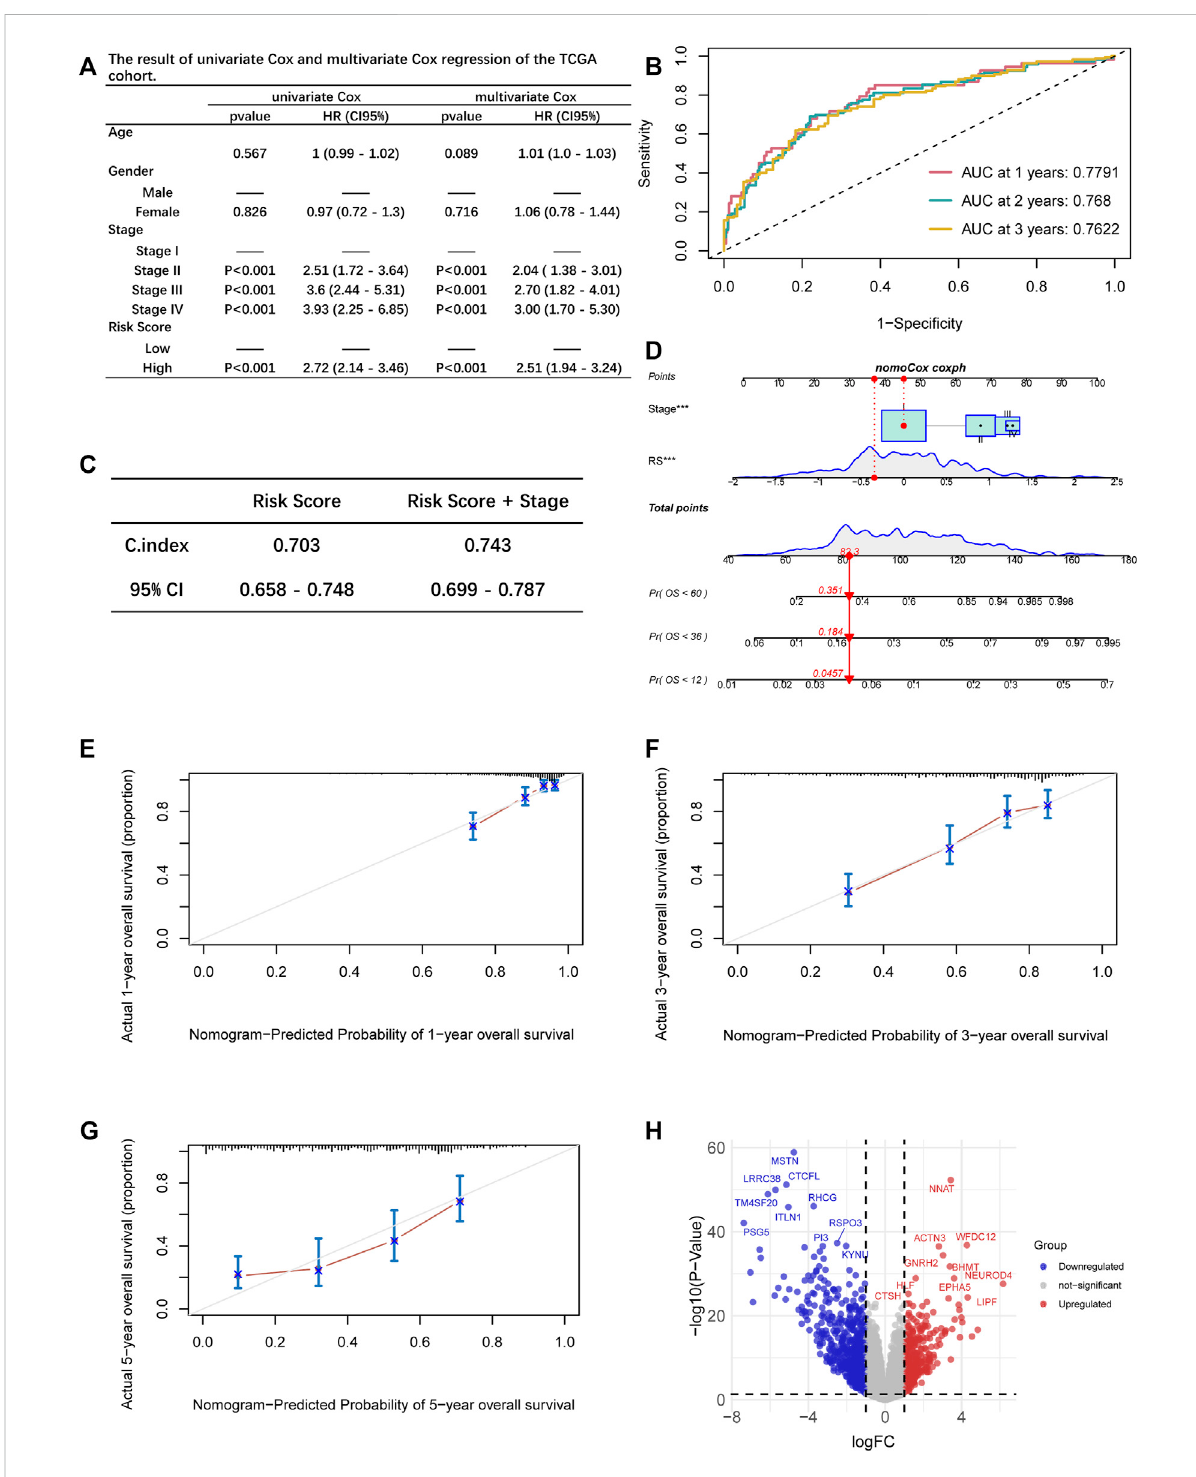
FIGURE 5 (A) Uni- and multivariate Cox regression analysis of the associations between survival outcomes and age, gender, stage, and risk score of LUAD patients. (B) ROCcurvesofone-,two-,and3-yearOSforLUADpatientsbasedontheRSandTNMstage. (C) Thecomparisonofthepredictionability betweenthetwomodel. (D) Thenomogramoftheoverallsurvivalpredictionmodel. (E – G) Calibrationplotsforthenomogram:1-year (E) ;3-year (F) ; 5-year (G) nomogram. (H) Volcano plot of differentially expressed genes between the two